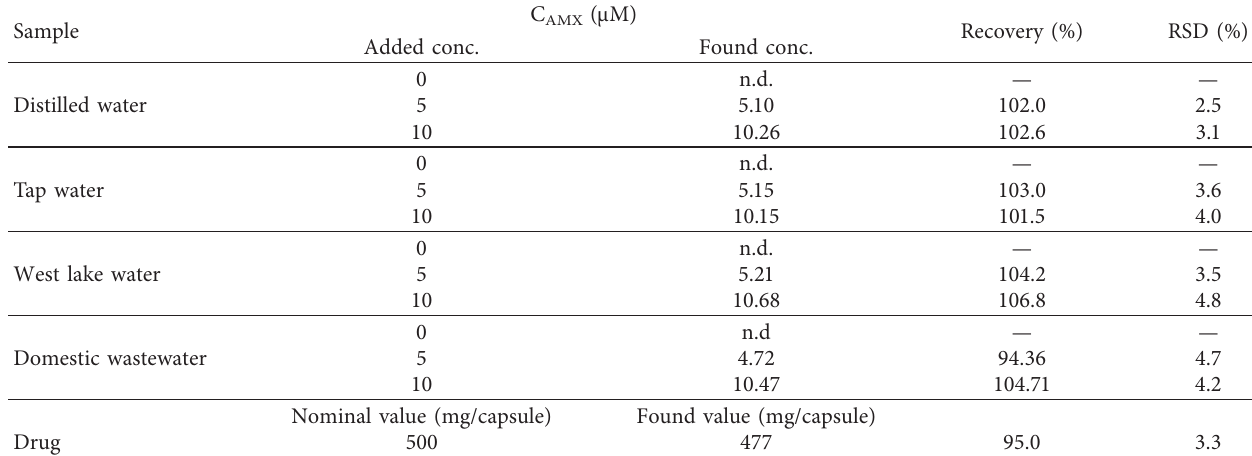
Table 2: Analytical results for the electrochemical determination of amoxicillin ( n � 3) using the RGOnS electrode in different water